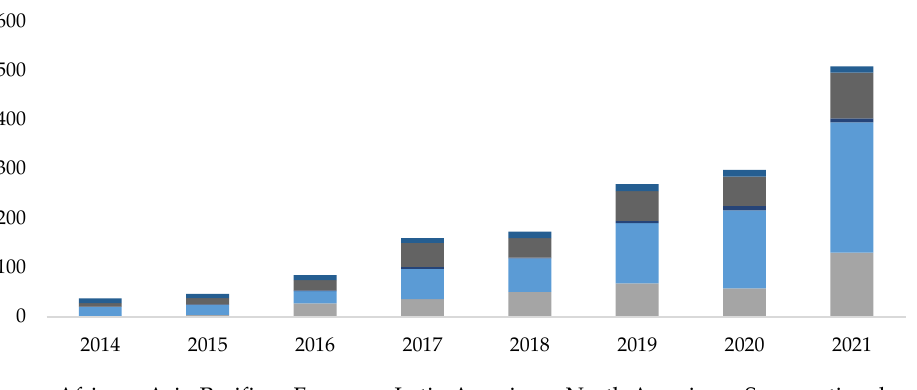
Figure 1. Green bond regional issuance by years (2014–2021). Source: climatebonds.net (accessed on 3 January 2023).